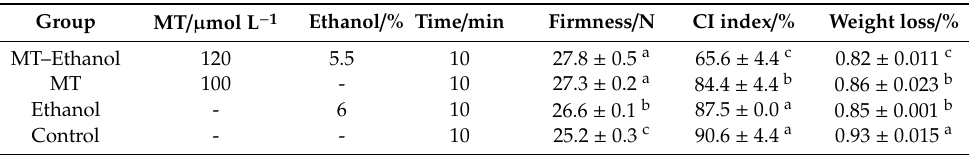
Table 5. Results of validation tests for